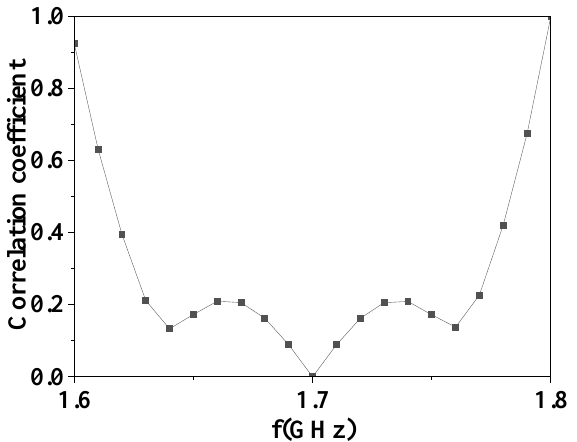
Figure 13. Correlation coefficient of the transmission matrix for multiple PIM sources. The imaging result of the center frequency is shown in Figure 14.